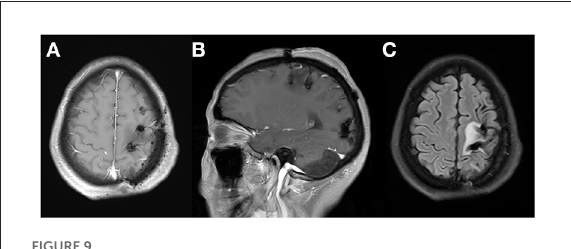
FIGURE9 Follow-up MRI revealed no signs of recurrence of tumors and gradually lessening ede-ma surrounding lesions without midline shift and obvious gadolinium enhancement. Axial (A) , sagittal (B) , and enhanced T1WI, FLAIR (C)